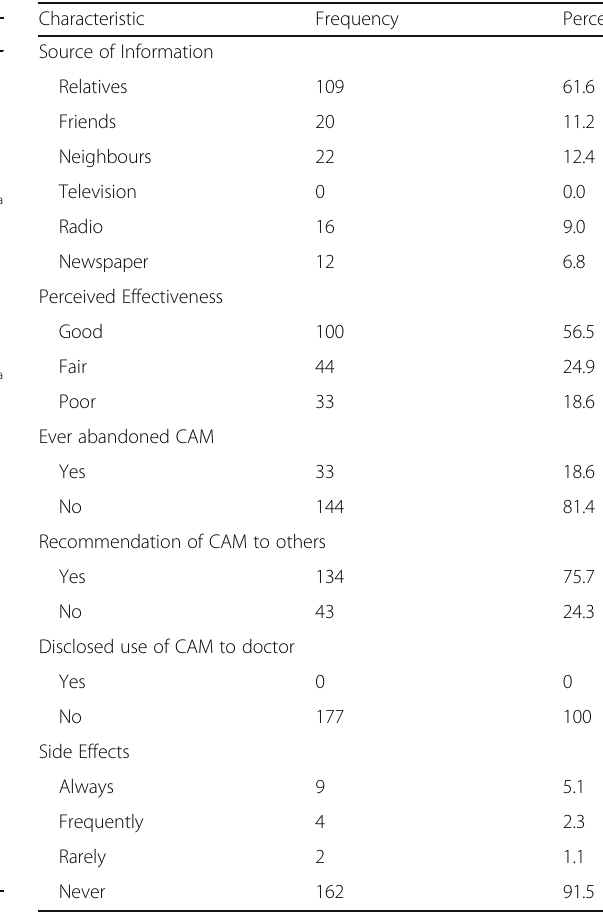
Table 4 Relationship between the demographic characteristics